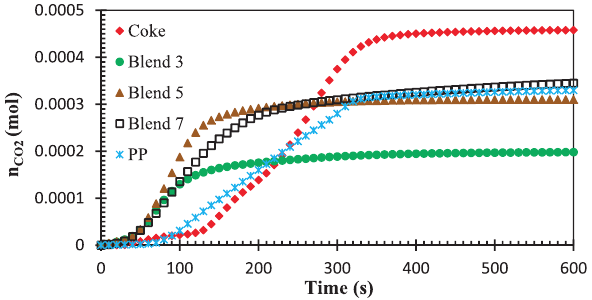
Fig. 13: Amount of CO 2 generated during reduction of FeO in slag by various reductants at 1500